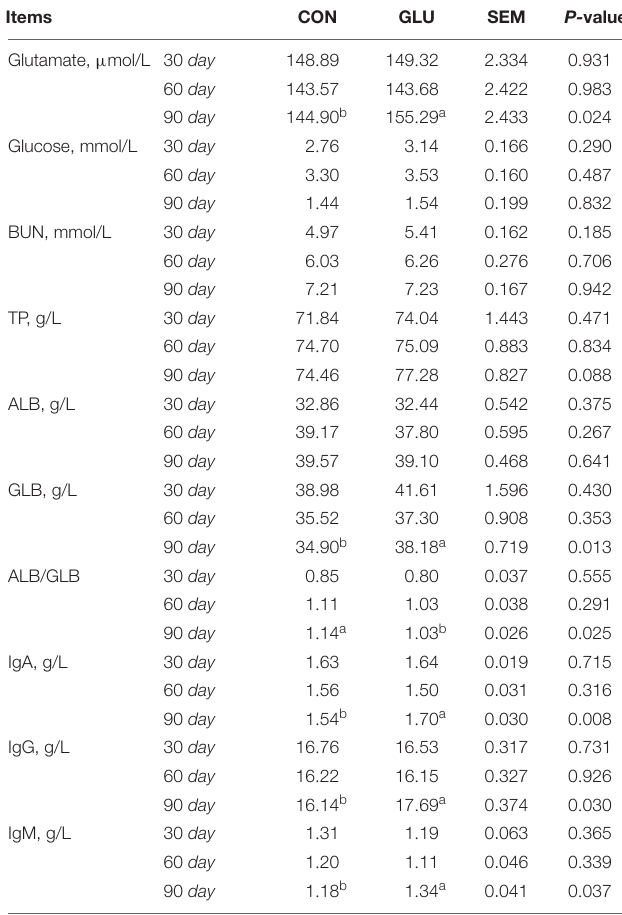
TABLE 7 | Effects of glutamate supplementation on serum biochemistry of heat-stressed Hu sheep ( n = 6) 1 .